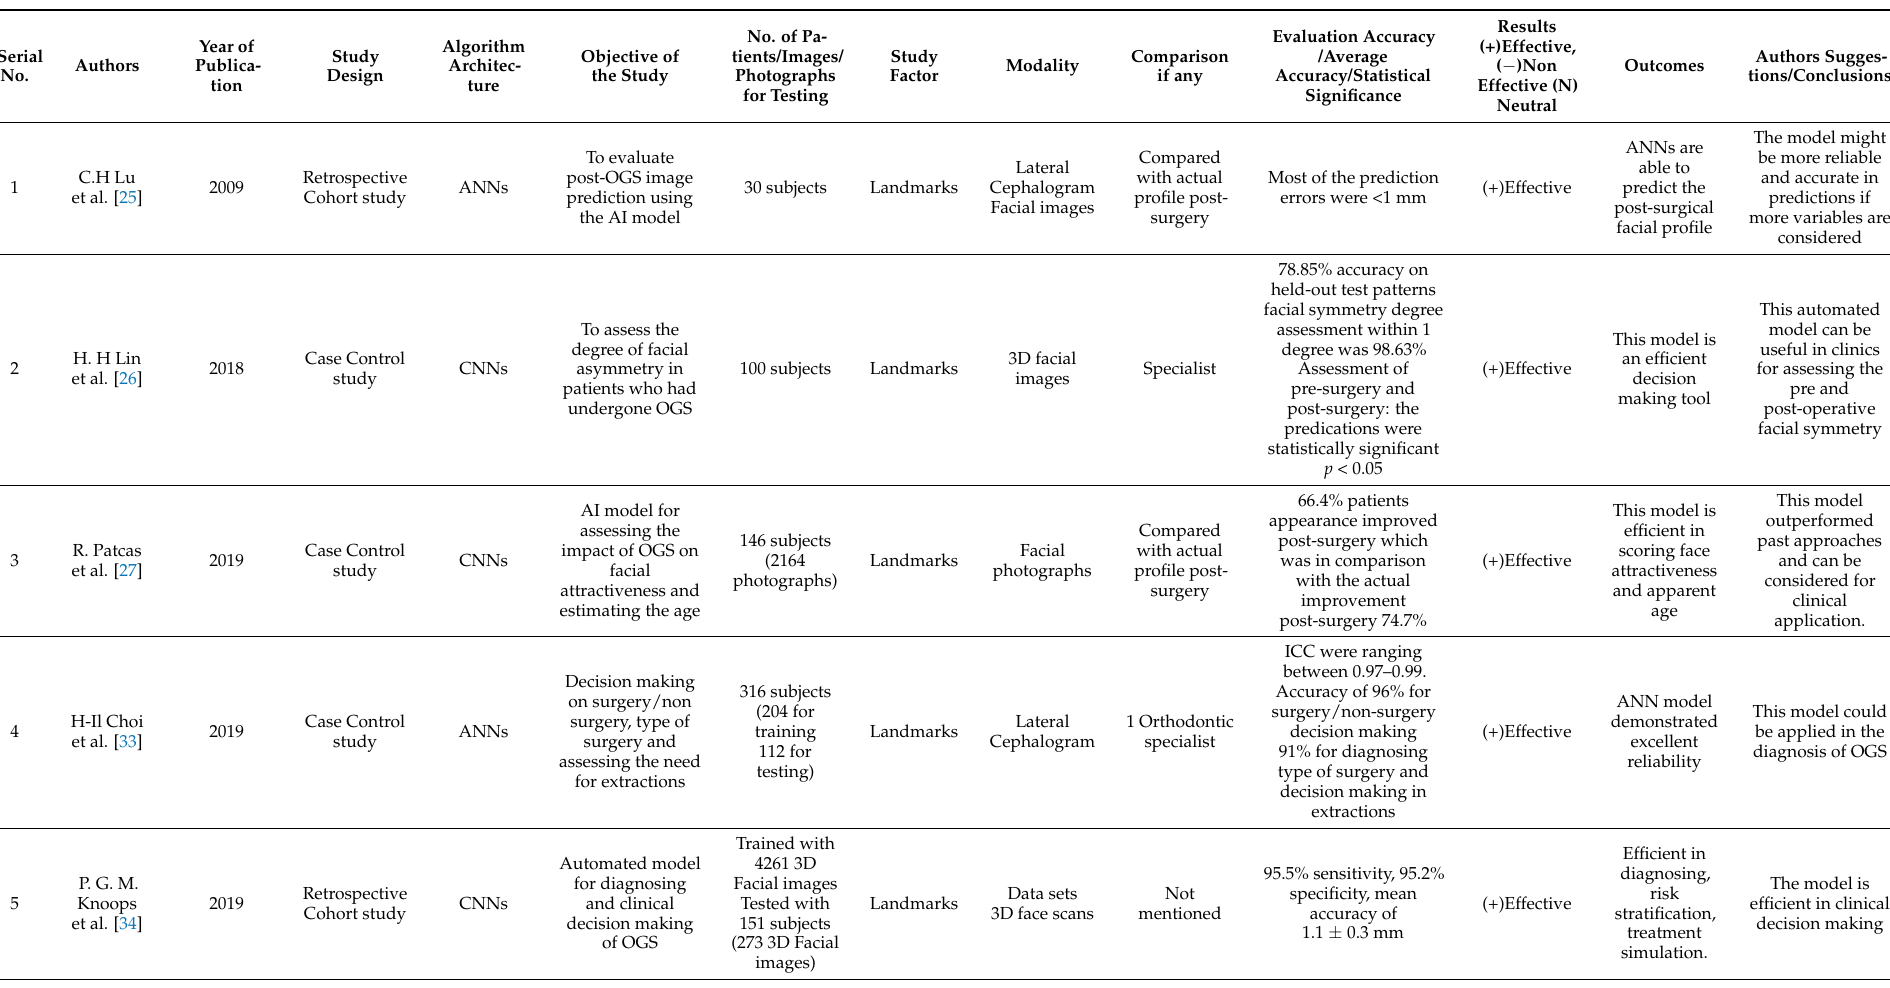
Table 2. Details of the studies that have used AI-based models in the diagnosis, treatment planning and prognosis of